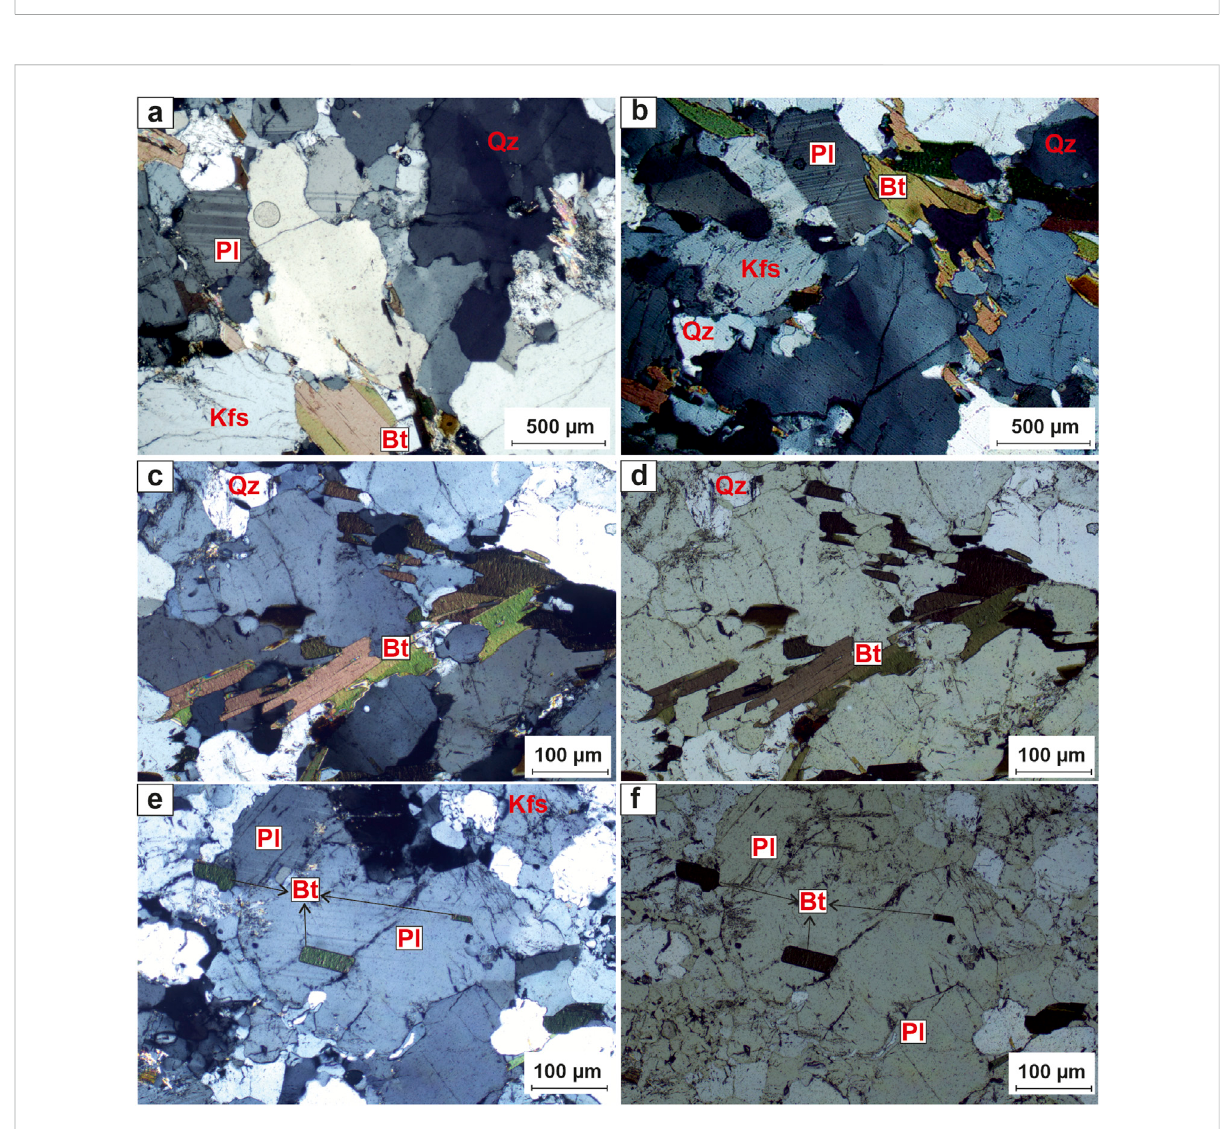
FIGURE 3 (A – F) Microphotograph of the tonalite gneiss SM 4 M mainly consists of quartz (Qz), K-feldspar (Kfs), plagioclase (Pl), and biotite (Bt).